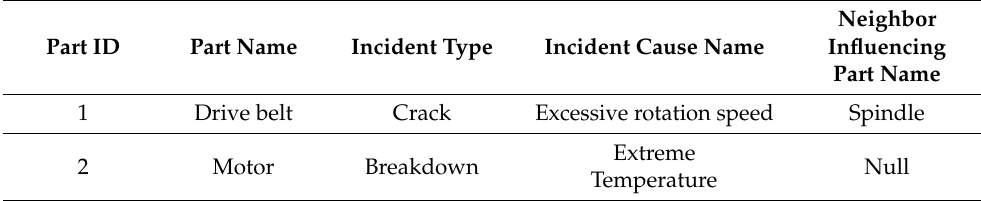
Table 5. The critical parts’ names, the types of incidents that occurred on them, and the names of their neighbor influential